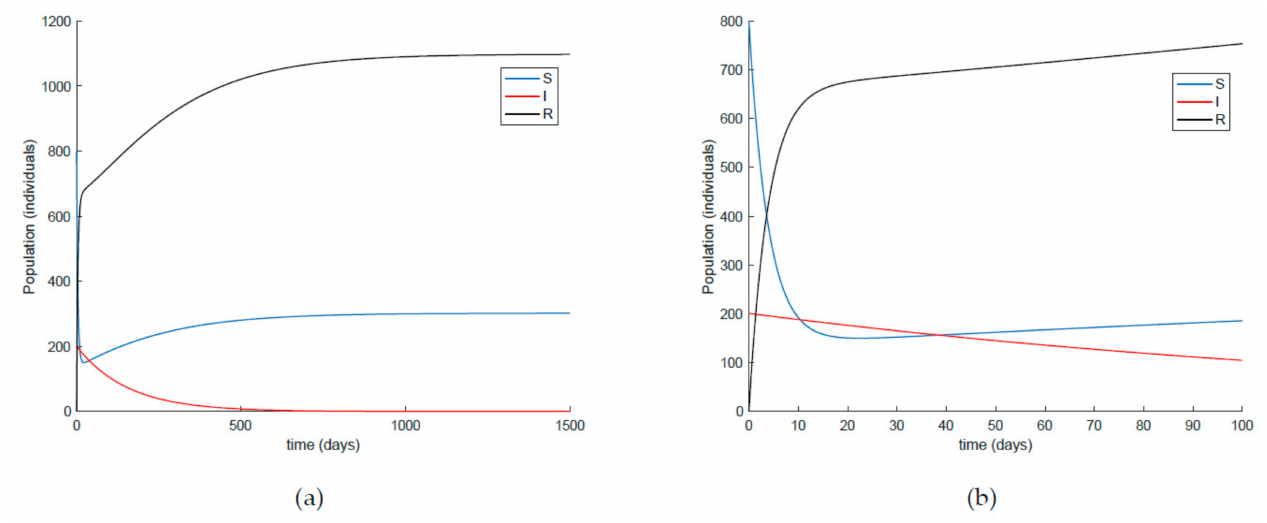
Figure 7. ( a ) Evolution of the system when β is fixed through Equation (30) ( λ = 0.9) and a constant vaccination term of 20% of the susceptible individuals is also employed. ( b ) Detail of the simulation for the first 100